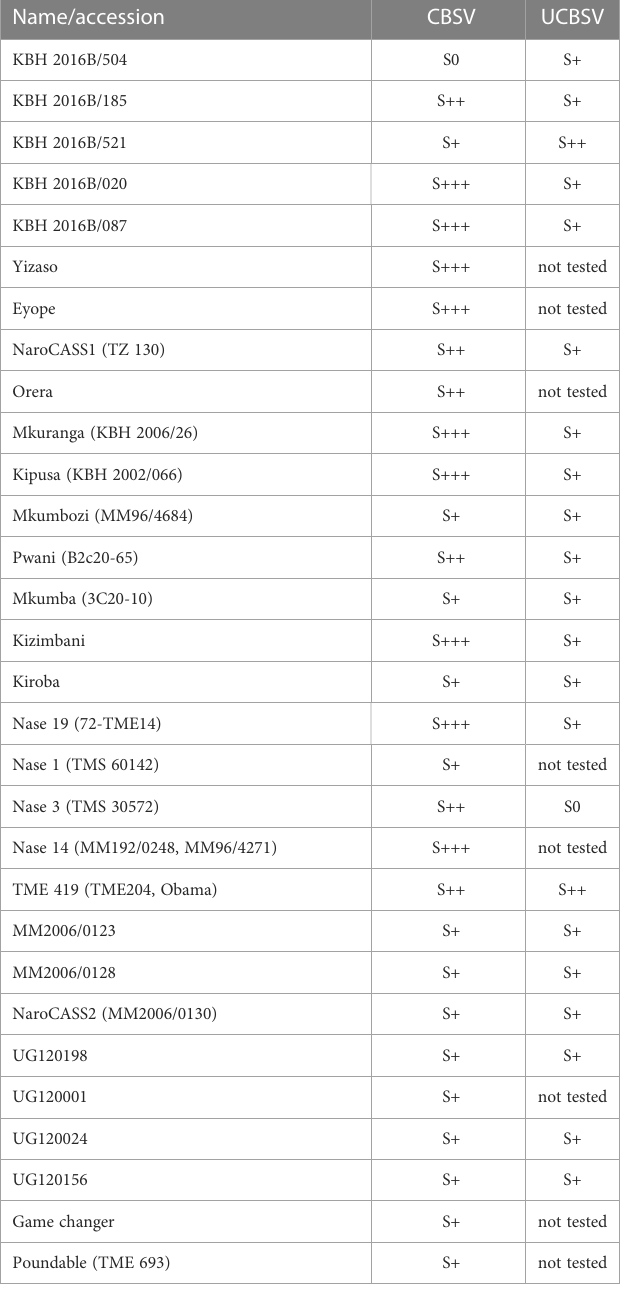
TABLE 1 Response of cassava lines and varieties upon infection with CBSV and